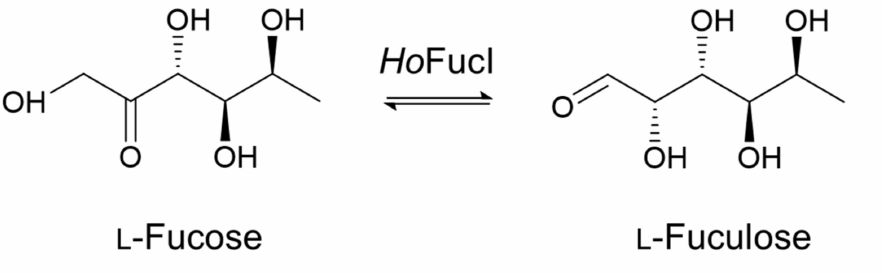
Figure 1. A scheme for interconversion between L -fucose and L -fuculose catalyzed by Ho